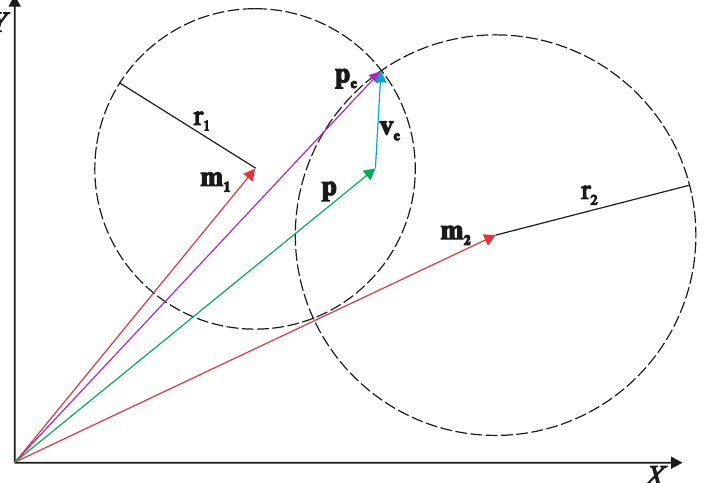
Figure 5. Determination scheme of position correction vector when two markers are